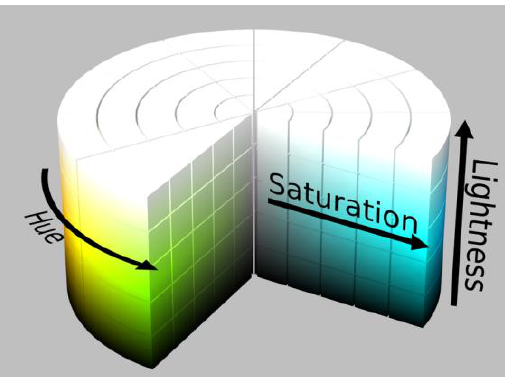
Figure 5. HSL color model.